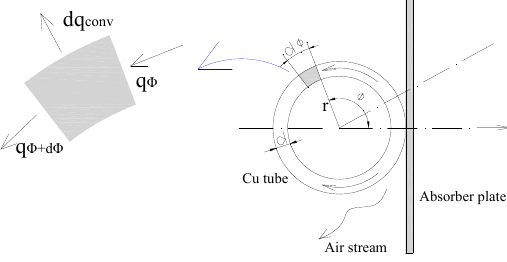
Figure 4. The schematic of the absorber plate welded with Cu-tubes.